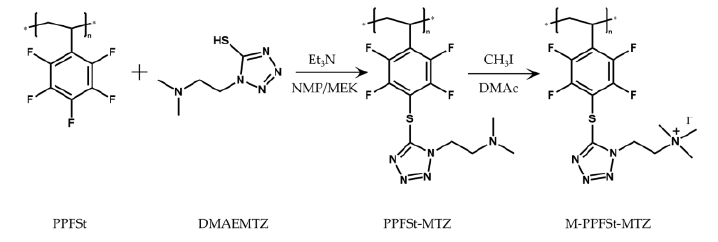
Figure 1. Anion exchange polymer preparation.